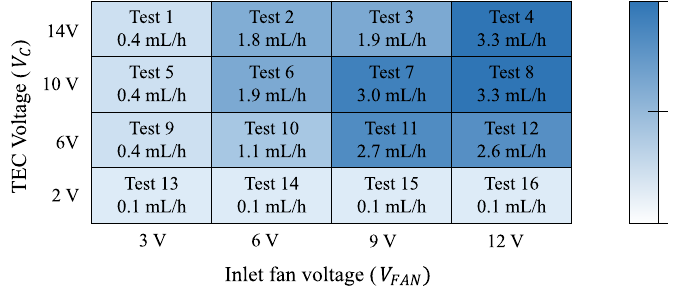
Figure 12. Color map of the generated water